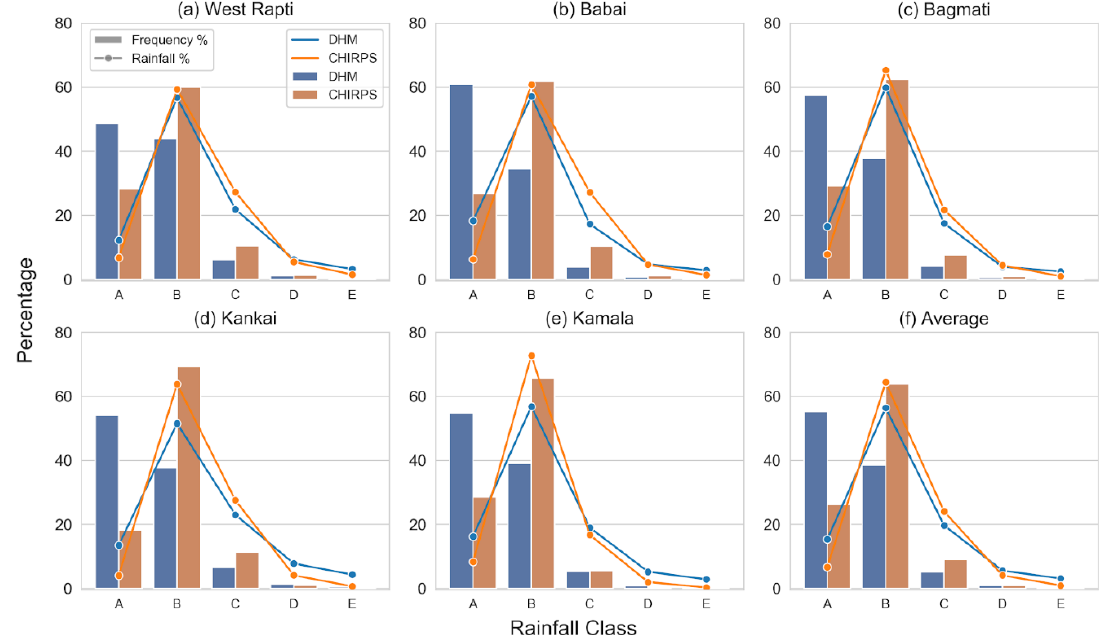
Figure 8. Contribution of rainfall frequency (%) and cumulative rainfall (%) of CHIRPS and rain gauge observations (DHM) for various classes of rainfall rate at different basins, ( a ) West Rapti, ( b ) Babai, ( c ) Bagmati, ( d ) Kankai, ( e ) Kamala, and ( f ) Average. A description of different classes is shown in Table 2.